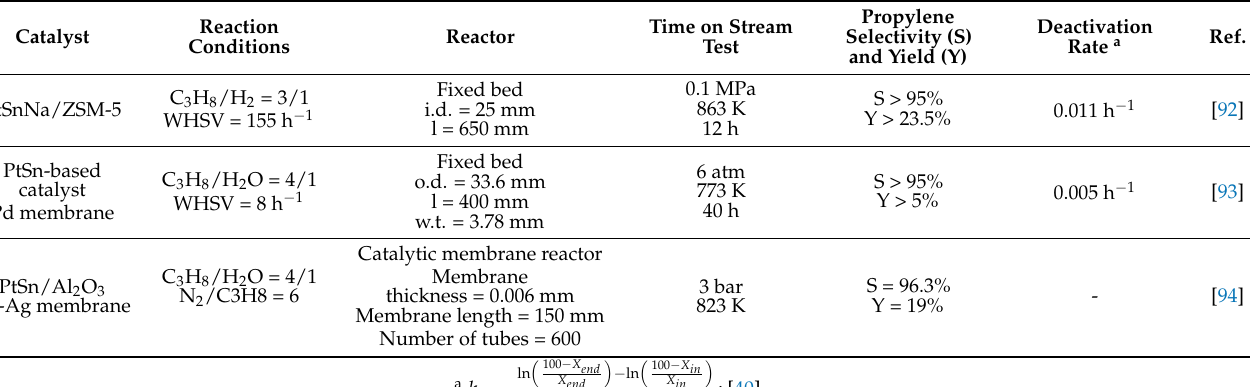
Table 3. Reactor configuration: reaction conditions, propylene selectivity and deactivation rate per selected catalyst of each article.